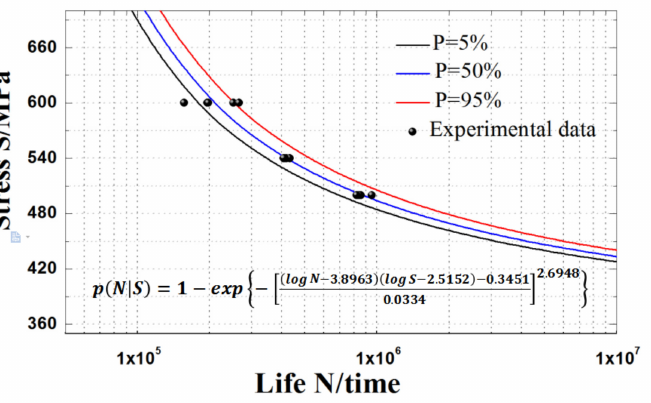
Figure 9. Fatigue S - N curve of HL-type ultra-high strength sucker rod obtained by the three- parameter Weibull distribution model under different failure probabilities.